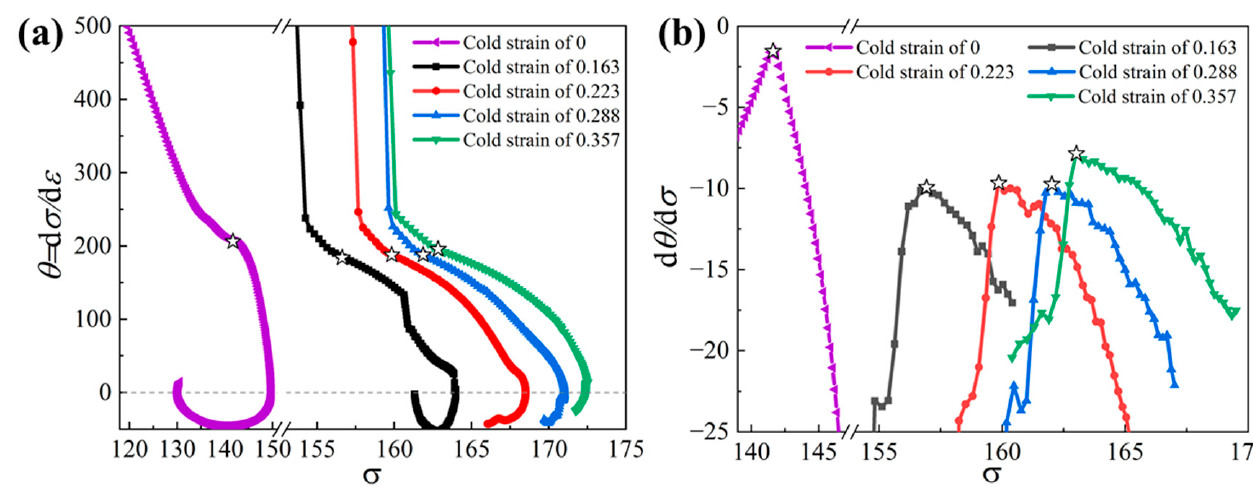
Figure 4. Curves of θ − σ ( a ) and d θ /d σ versus σ ( b ) of the specimens with different cold strains, subjected to thermal deformation at the temperature of 1323 K and a strain rate of 0.1 s − 1 . Table 2. Values of critical strain, ε c , and peak strain, ε p , under different cold strains.